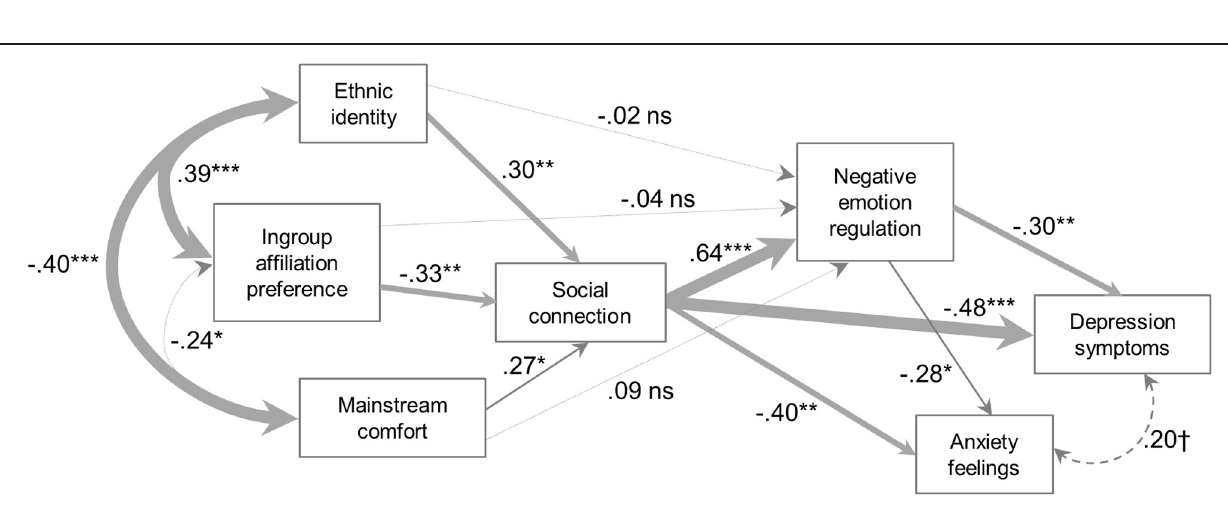
FIGURE 3 | Mexican/Mexican American (MA) participants ( N =